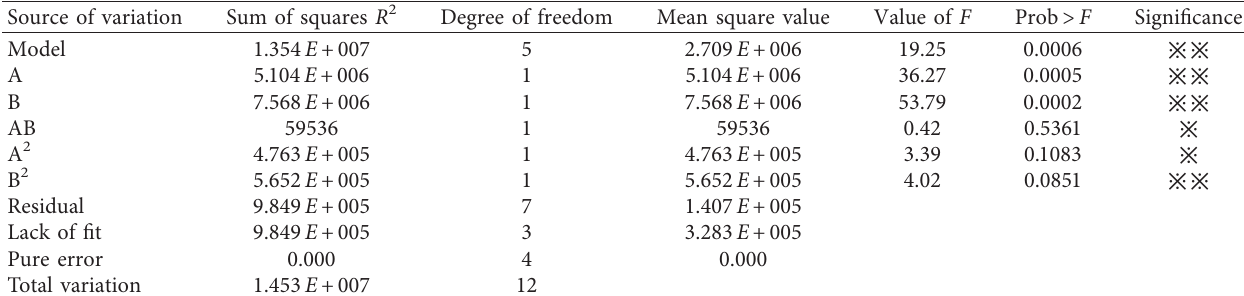
Table 8: Coefficient of regression equation and significance test for sliding friction.